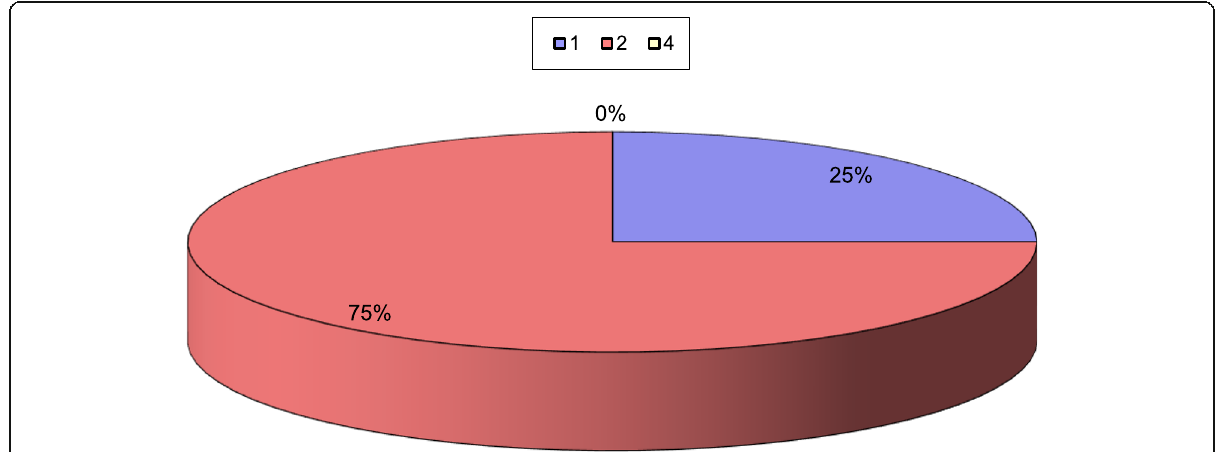
Fig. 8 The anxiety scores at 45 min after midazolam